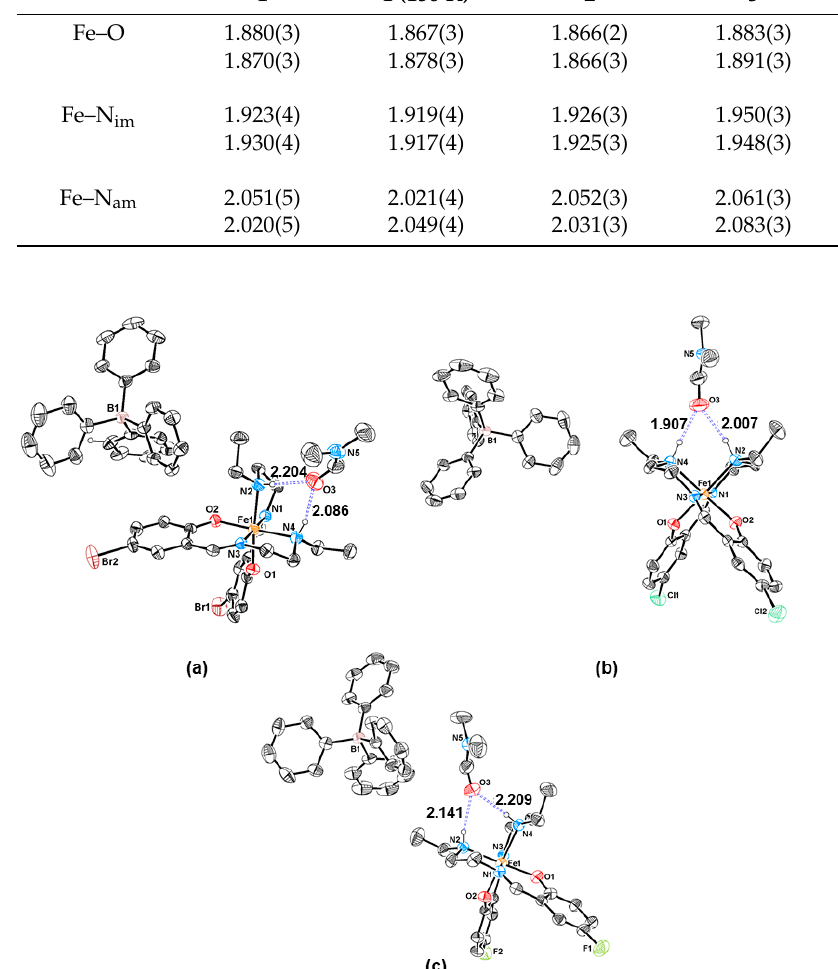
Figure 3. ORTEP-3 diagrams of complexes 1 ( a ), 2 ( b ), and 3 ( c ), using 30% probability level ellipsoids. All calculated hydrogen atoms are omitted for clarity. Hydrogen bonds between the DMF solvent molecule and the NH groups of the cation are depicted as dashed blue bonds with distances of 2.086 and 2.204 Å for ( a ), 1.907 and 2.007 Å for ( b ), and 2.141 and 2.209 Å for ( c ).